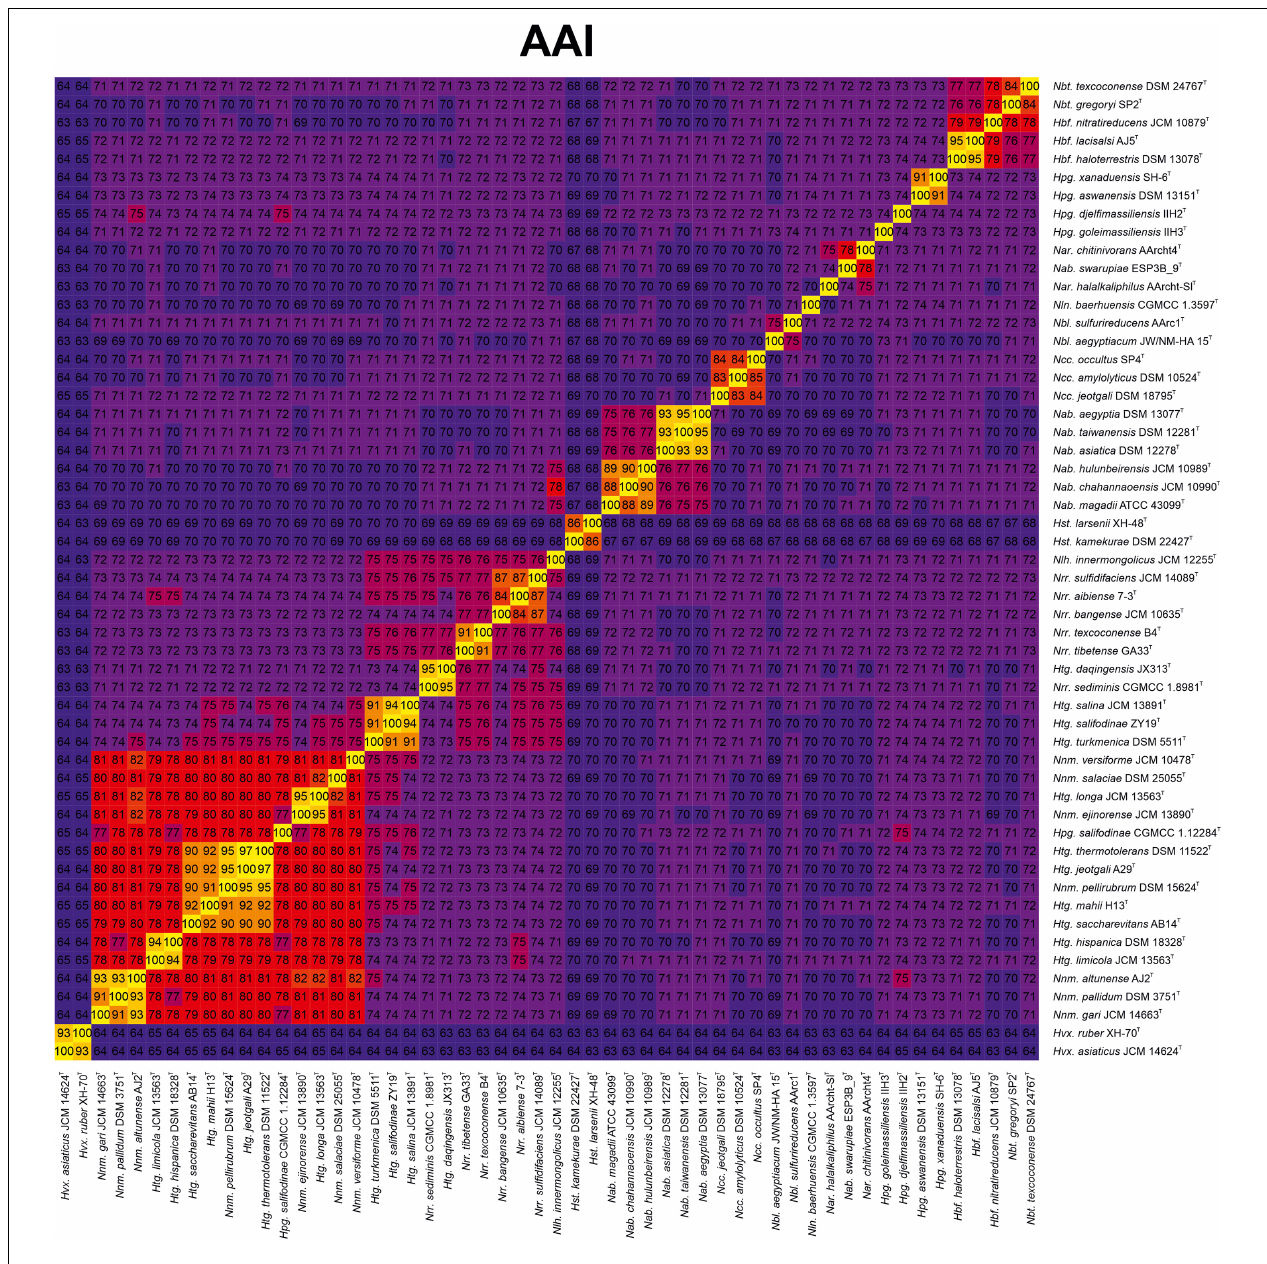
FIGURE 3 | Heatmap of AAI relatedness among the type strains of members of the genera Natrinema and Haloterrigen a and representatives of the other genera of the family Natrialbaceae